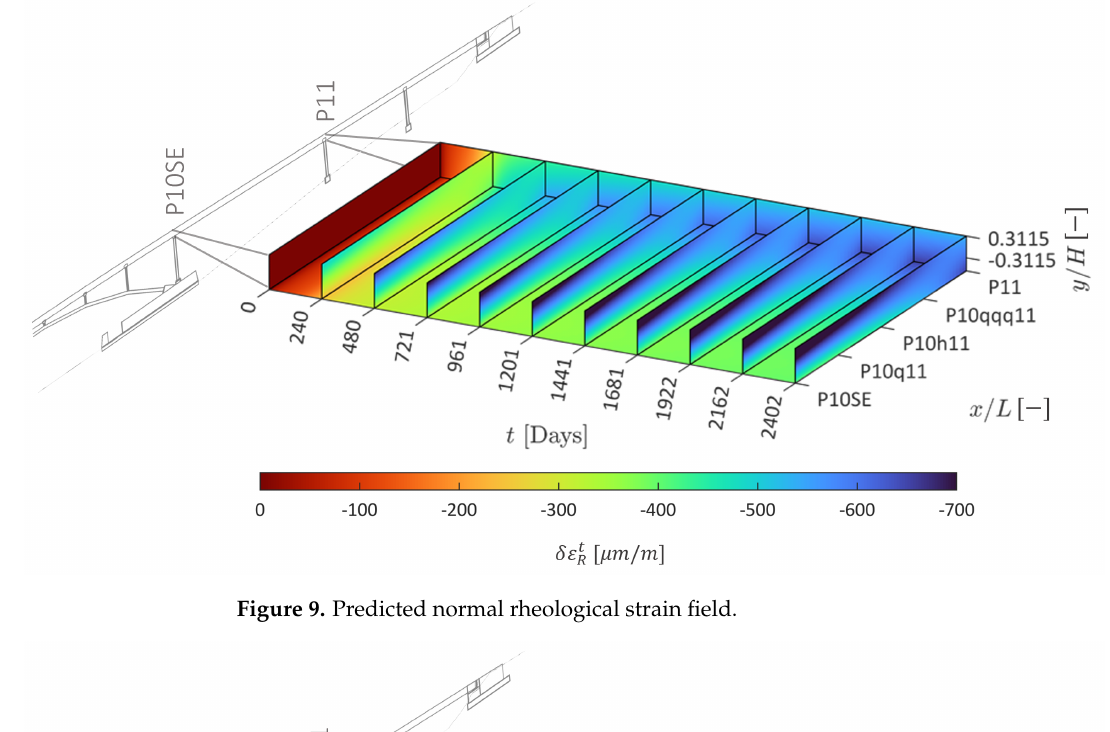
Figure 9. Predicted normal rheological strain field.